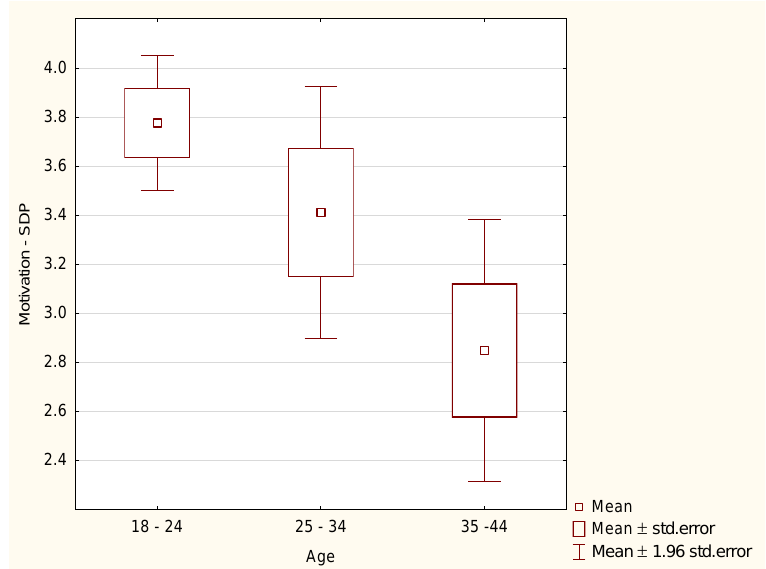
Figure 13. SDP as a factor influencing the transport choice in different age groups. The education industry stands out from the crowd in terms of comfort and safety. In this case, the Kruskal–Wallis rank ANOVA test gave a result of 12.537, which translates into the test probability of p = 0.0138. This indicates significant differences in the level of motivation that own comfort and safety provide when choosing a means of transport, as shown in Figure 14.